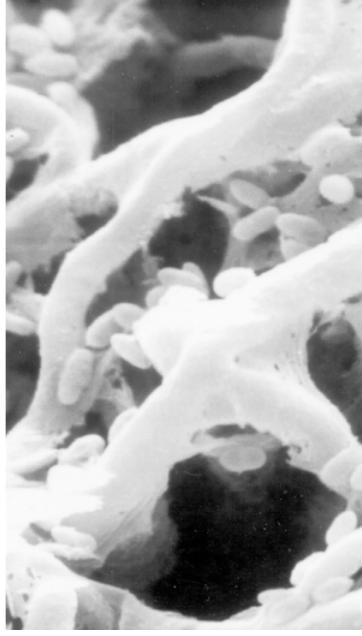
Fig. 4. Conidia of Phoma septicidalis (SEM x 2600). Phot. M. Wróbel.